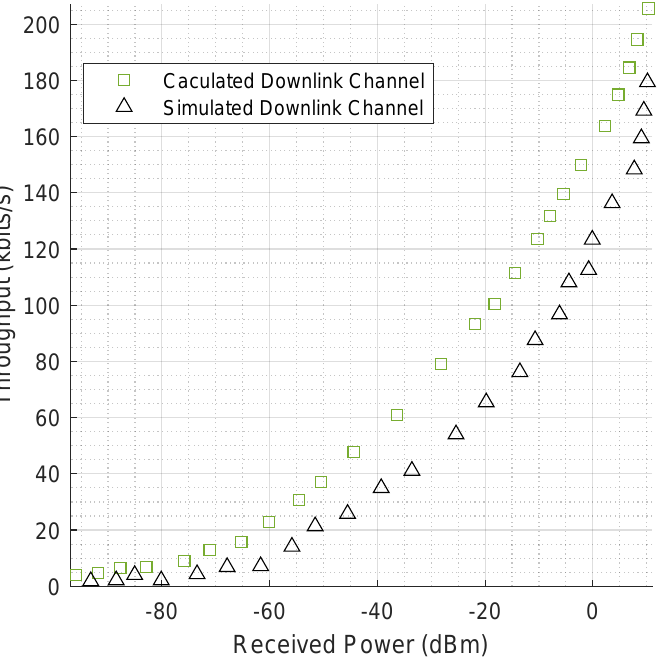
Figure 8. Both simulated and calculated throughput measurements (kbits/s) for NB-IoT downlink channels which are based on the received power